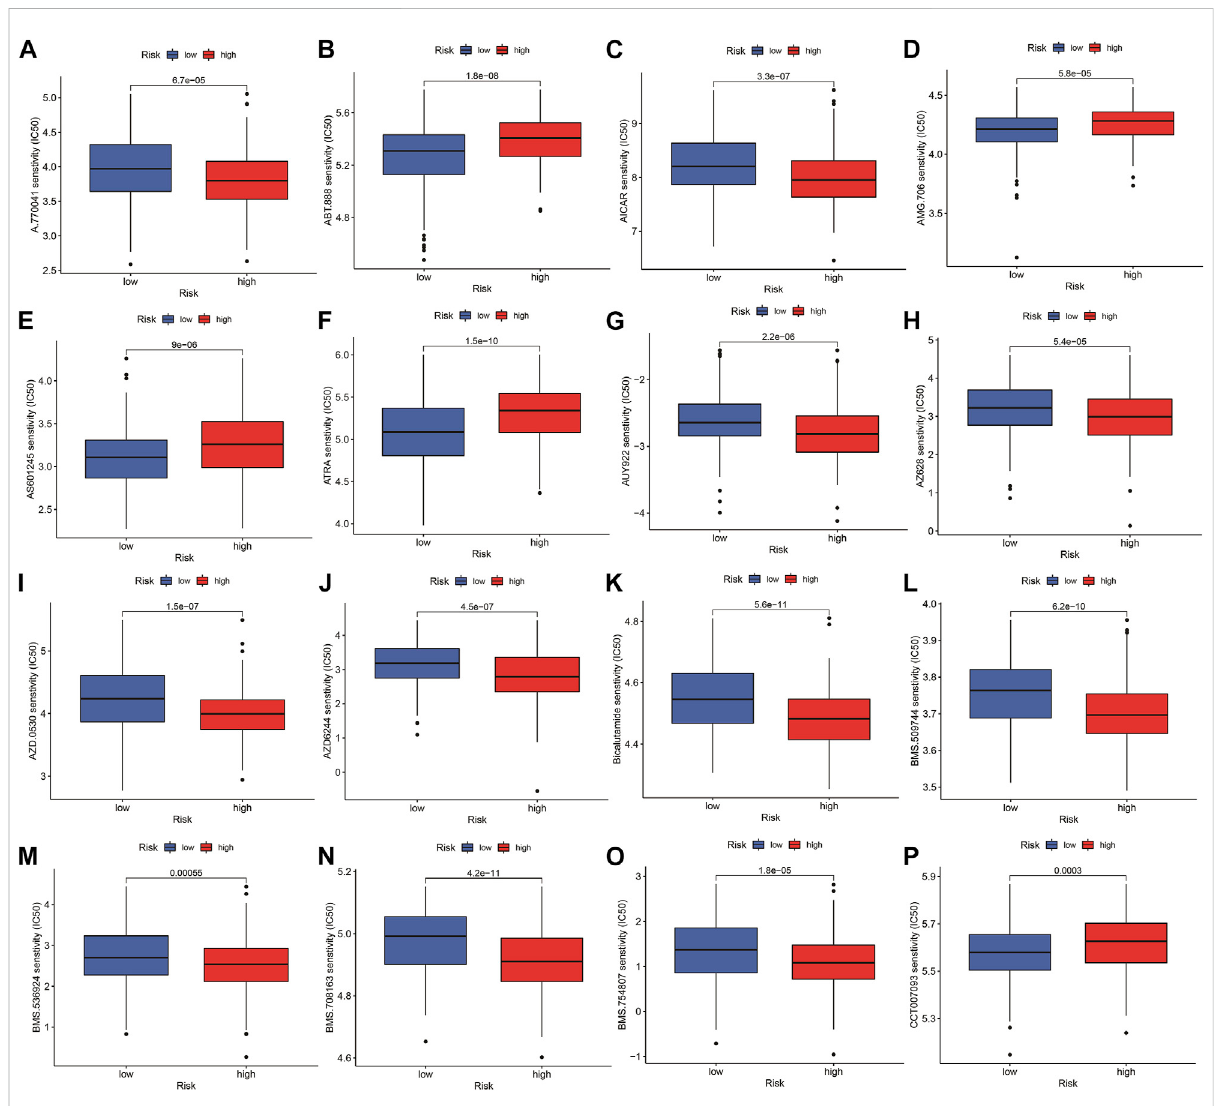
FIGURE 14 Comparison of drug sensitivity between high- and low-risk groups. (A – P) Drug sensitivity between high- and low-risk